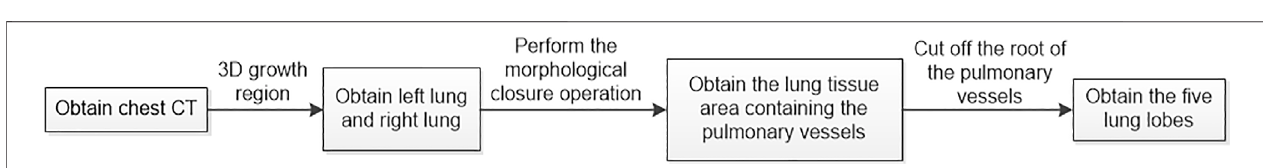
FIGURE 2 | The principle fl owchart of lung lobes